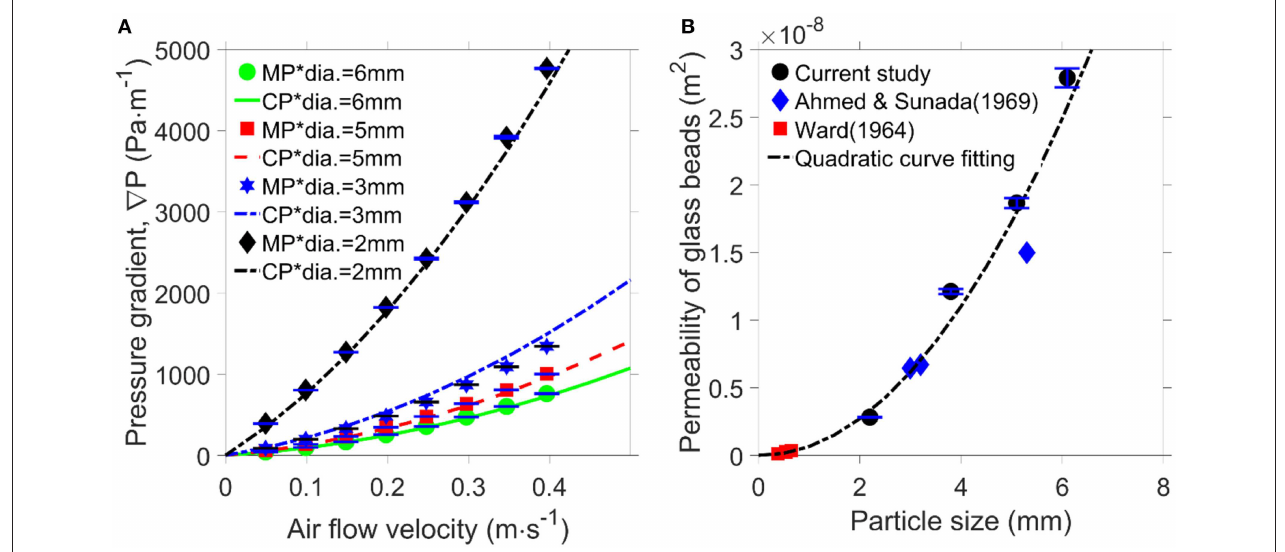
FIGURE 4 | Spherical glass bead particle results. (A) Pressure gradient as a function of air flow velocity for various sized particles. MP* is the measured pressure gradient and CP* is the calculated pressure gradient calculated using the Kozeny-Carman equation. (B) Air permeability measurement compared with previous studies (Ward, 1964; Ahmed and Sunada, 1969).